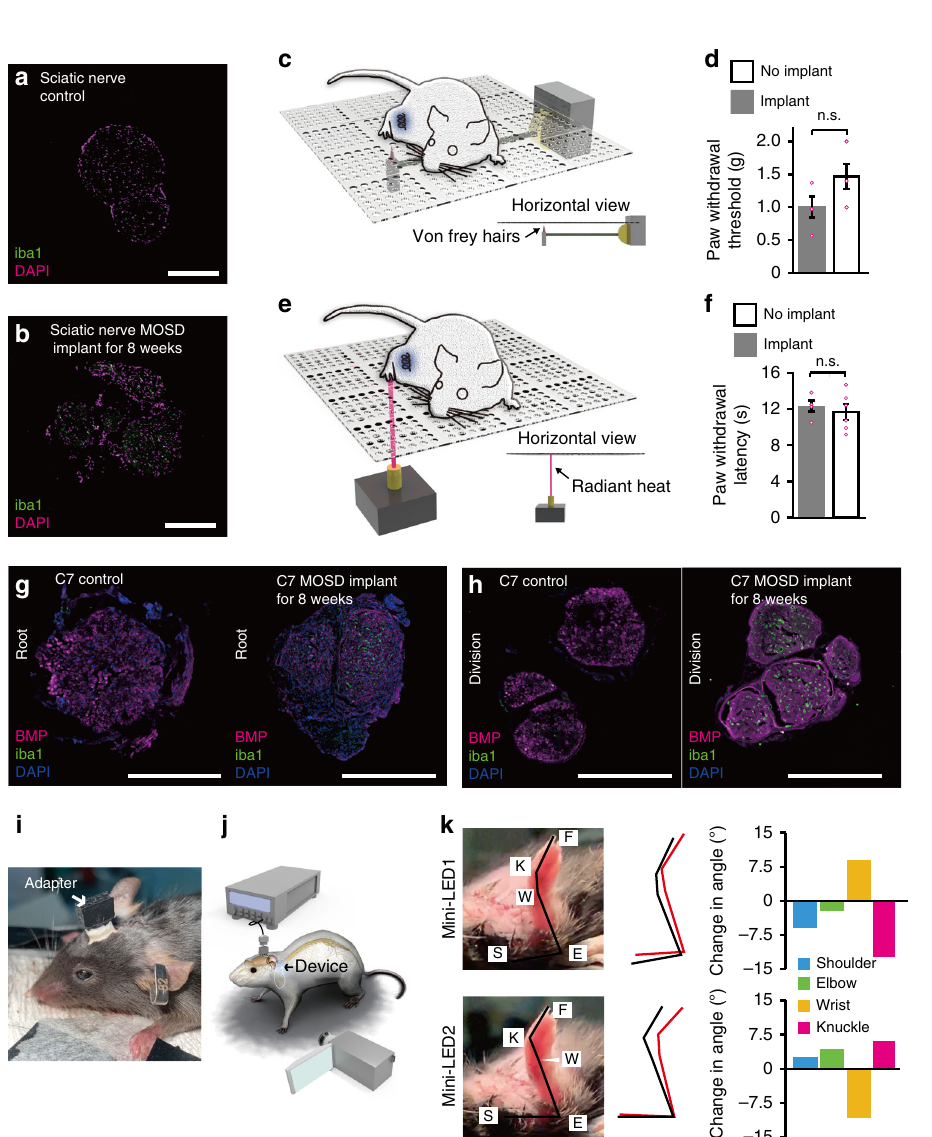
Fig. 7 Biocompatibility and effectiveness of MOSD after 8-week implant. a , b Immunostaining of mice sciatic nerve after 8 weeks MOSD implant. c , d Withdrawal latency of mice in von Frey test. MOSD were implanted into sciatic nerve for 4 weeks. n implant = 4 mice, n no implant = 6 mice, Unpaired t- test. e , f Withdrawal latency of mice in Hargreaves test. MOSD were implanted into sciatic nerve for 4 weeks. Sham operation group were taken as control. n implant = 4 mice, n no implant = 6 mice, Unpaired t- test. g , h Immunostaining of mice C7 nerve after 8 weeks MOSD implant in the root and division end. i , j Schematics and images of mice with MOSD implant. Adapter for the MOSD implant was fi xed onto the skull. k Different upper limb movements were elicited by mini-LEDs of MOSD (81.6 mW, calculated light intensity at the distal end was 539.2 mW mm − 2 , 20 msec-on/2 sec-off) 3 weeks after the C7 implant. Black lines represented the position of upper limb before mini-LED stimulation. Red lines represented the position of upper limb after mini-LED stimulation. Data are presented as mean ± s.e.m. Scale bars are 200 µ m ( a , b , g , h